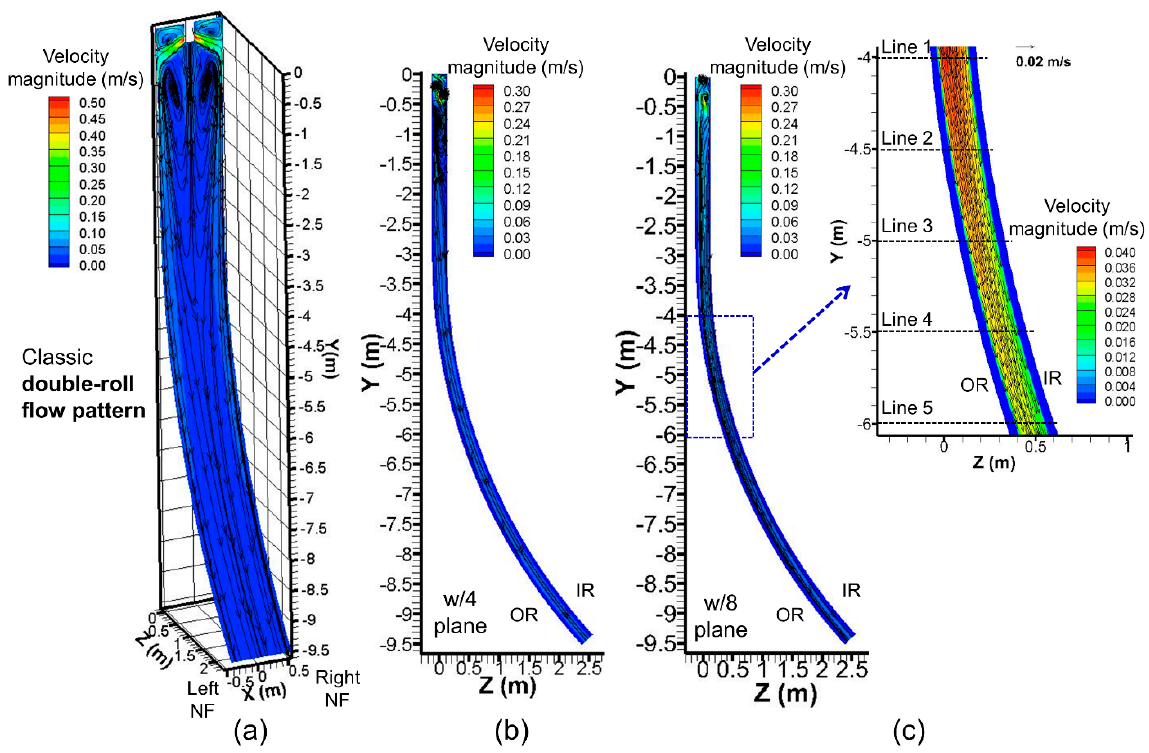
Figure 5. Flow pattern and velocity at ( a ) the center middle-plane (3D view between IR and OR), ( b ) the w/4 plane (side view midway between SEN and NF), and ( c ) the w/8 plane (side view near NF) in the strand with close-up.